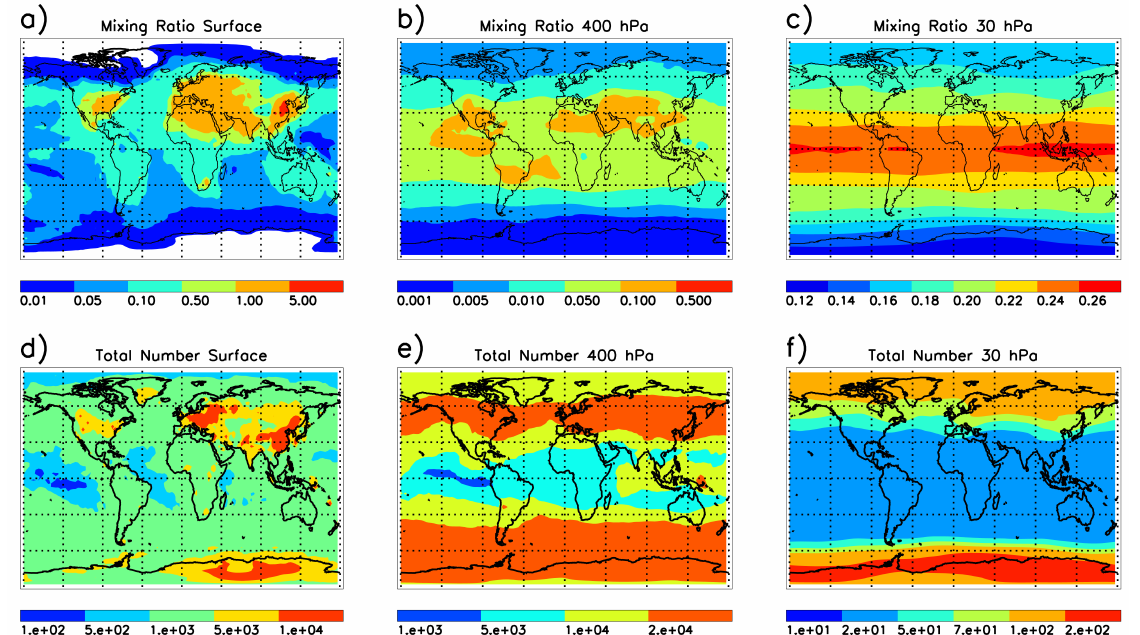
Fig. 6. Global distribution of modelled annual mean sulphate aerosol mixing ratios (top row) and total particle number concentrations (bottom row) in the last year of integration at the surface (a and d), in the free troposphere at 400 hPa (b and e), and in the stratosphere at 30 hPa (c and f). Mixing ratios are expressed as ppbm and concentrations in cm − 3 .